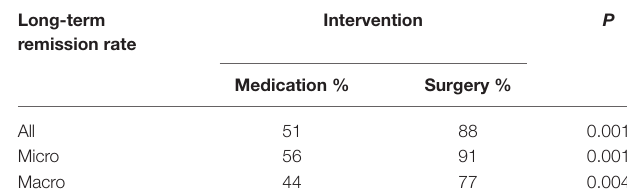
TABLE 2 | Differences in long-term remission rate of PRL between medication and surgery.